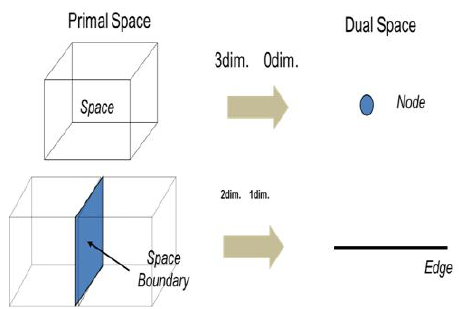
Figure 3. Basic concept of development for Indoor Spatial